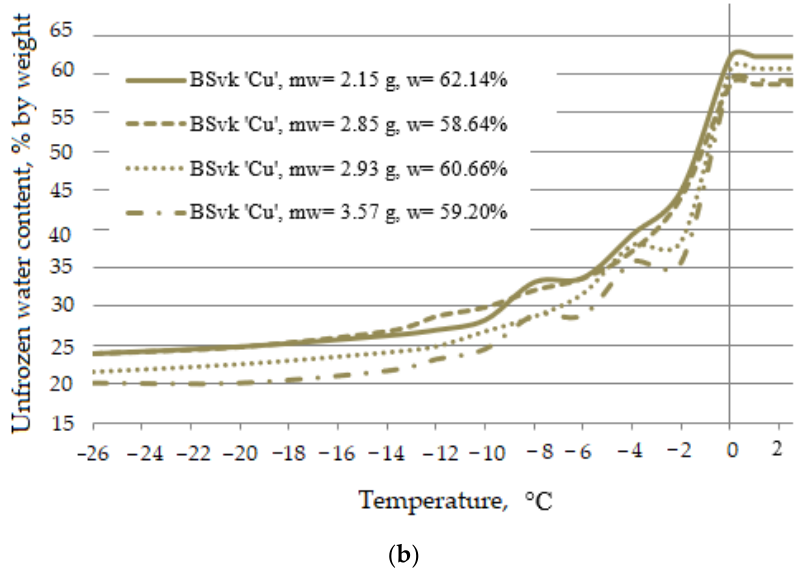
Figure 6. The curve of the unfrozen water content as a function of the temperature, depending on the type of copper bentonite ‘ Cu ’ ( a ) Stx-1b; ( b ) BSvk and the initial mass of water in the samples of the clays characterised by a similar moisture content; cycle 1. Table 5. Multiple regression analysis between the type of clay, the mass of water of the clay, the water content as a percentage of the dry mass, and the unfrozen water of the clay at selected temperatures in the temperature range ( − 26 °C to − 2 °C).